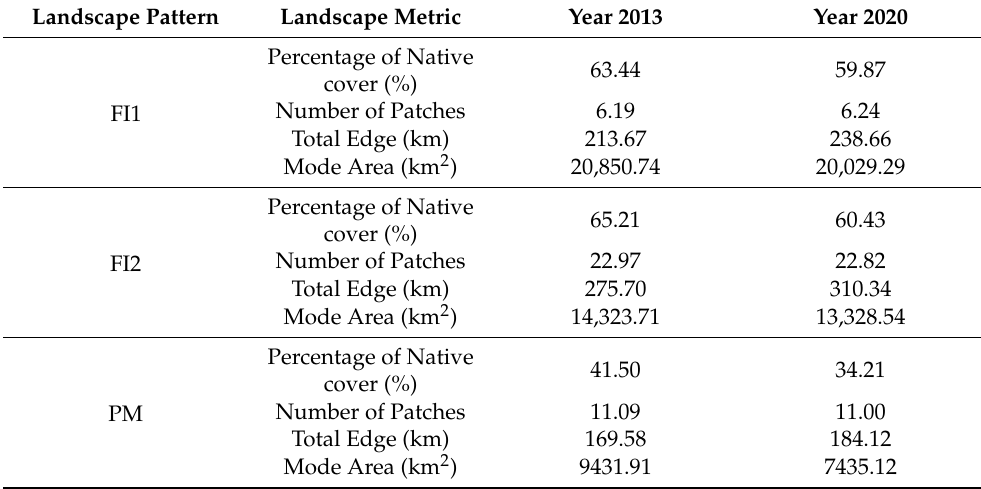
Table 2. Results of the metrics inside FI2 in 2013 and 2020 average values: Percentage of Native cover, Number of Patches, Total Edge, and Mode